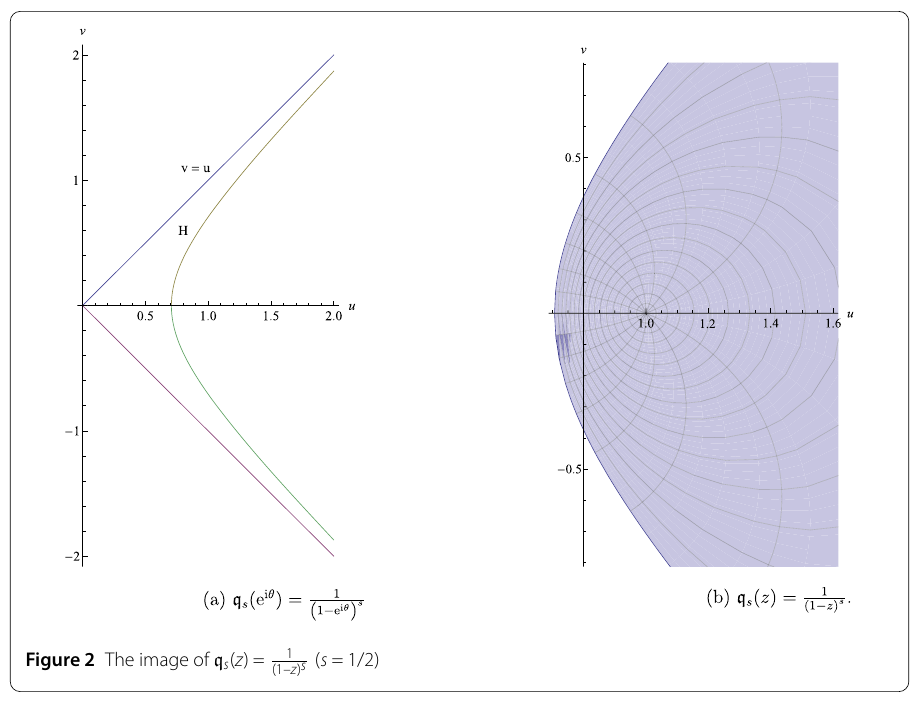
Figure 2 The image of q s ( z ) = 1